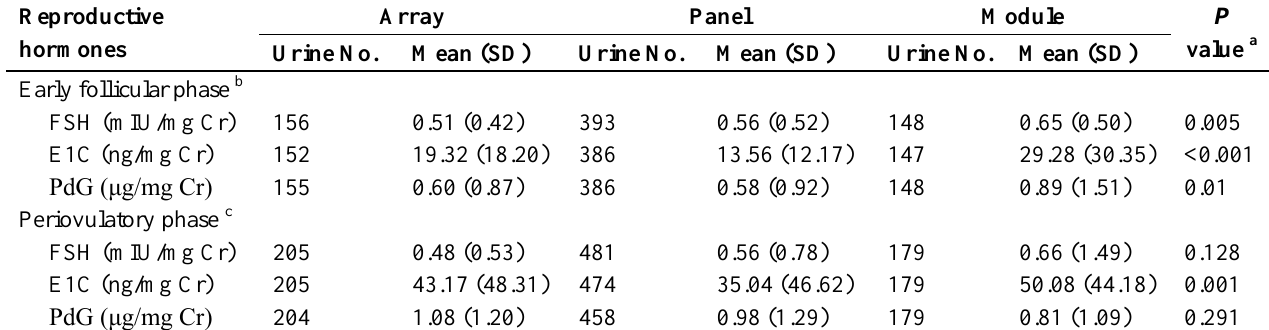
Table 3. The mean concentrations of reproductive hormones by three areas of fabrication.